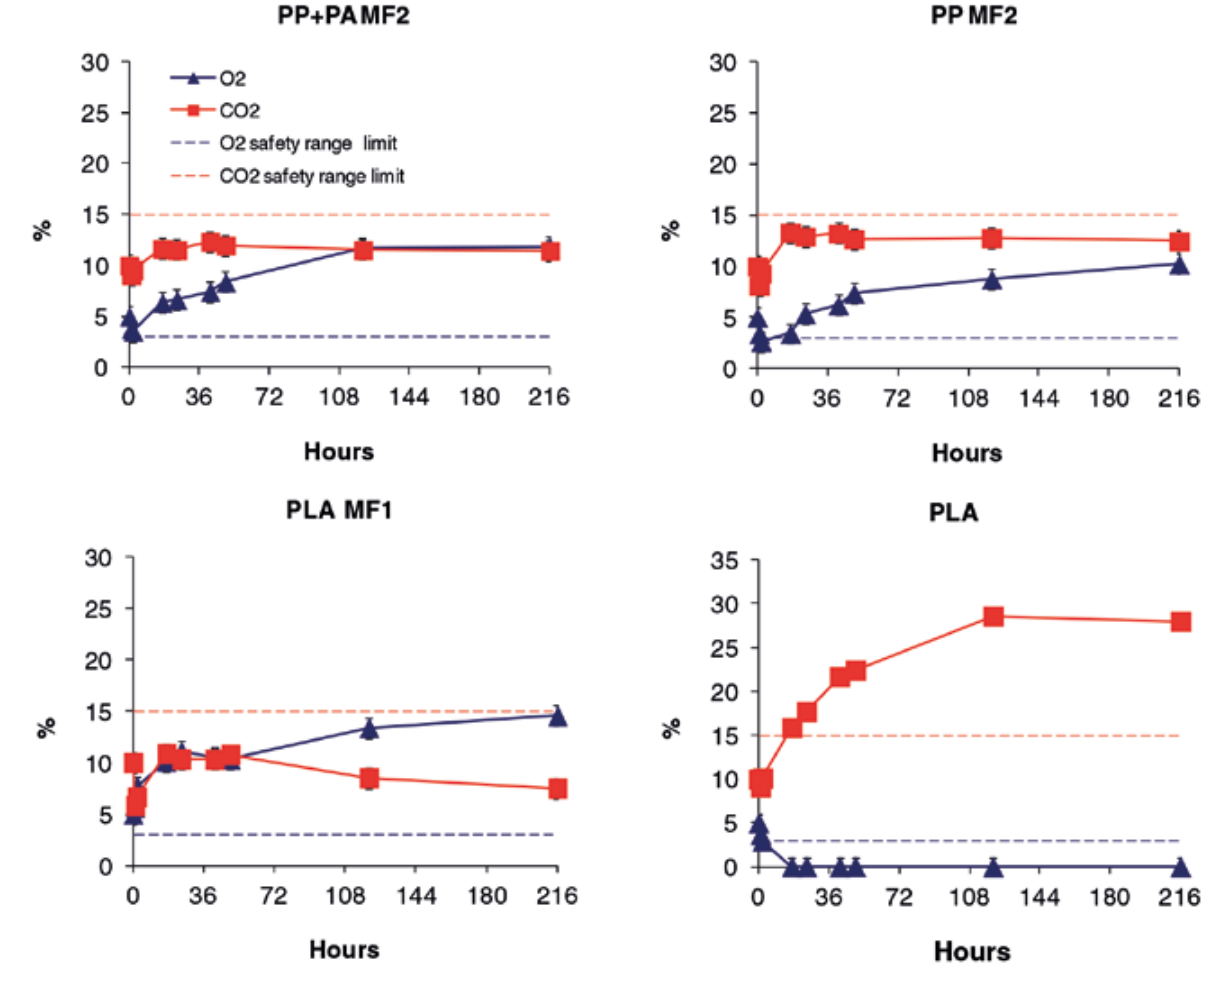
Fig. 1 - O and CO concentrations within different packages used for artichoke quarters stored at 4°C: PP+PAMF2 = polypropylene + polyamide 2 2 with two lines of micro-perforations; PP MF2 = polypropilene with two lines of micro-perforations; PLA MF1= polylactid acid with one line of micro-perforation; PLA= polylactic acid without micro-perforation. Mean values of three replicates ± STD.